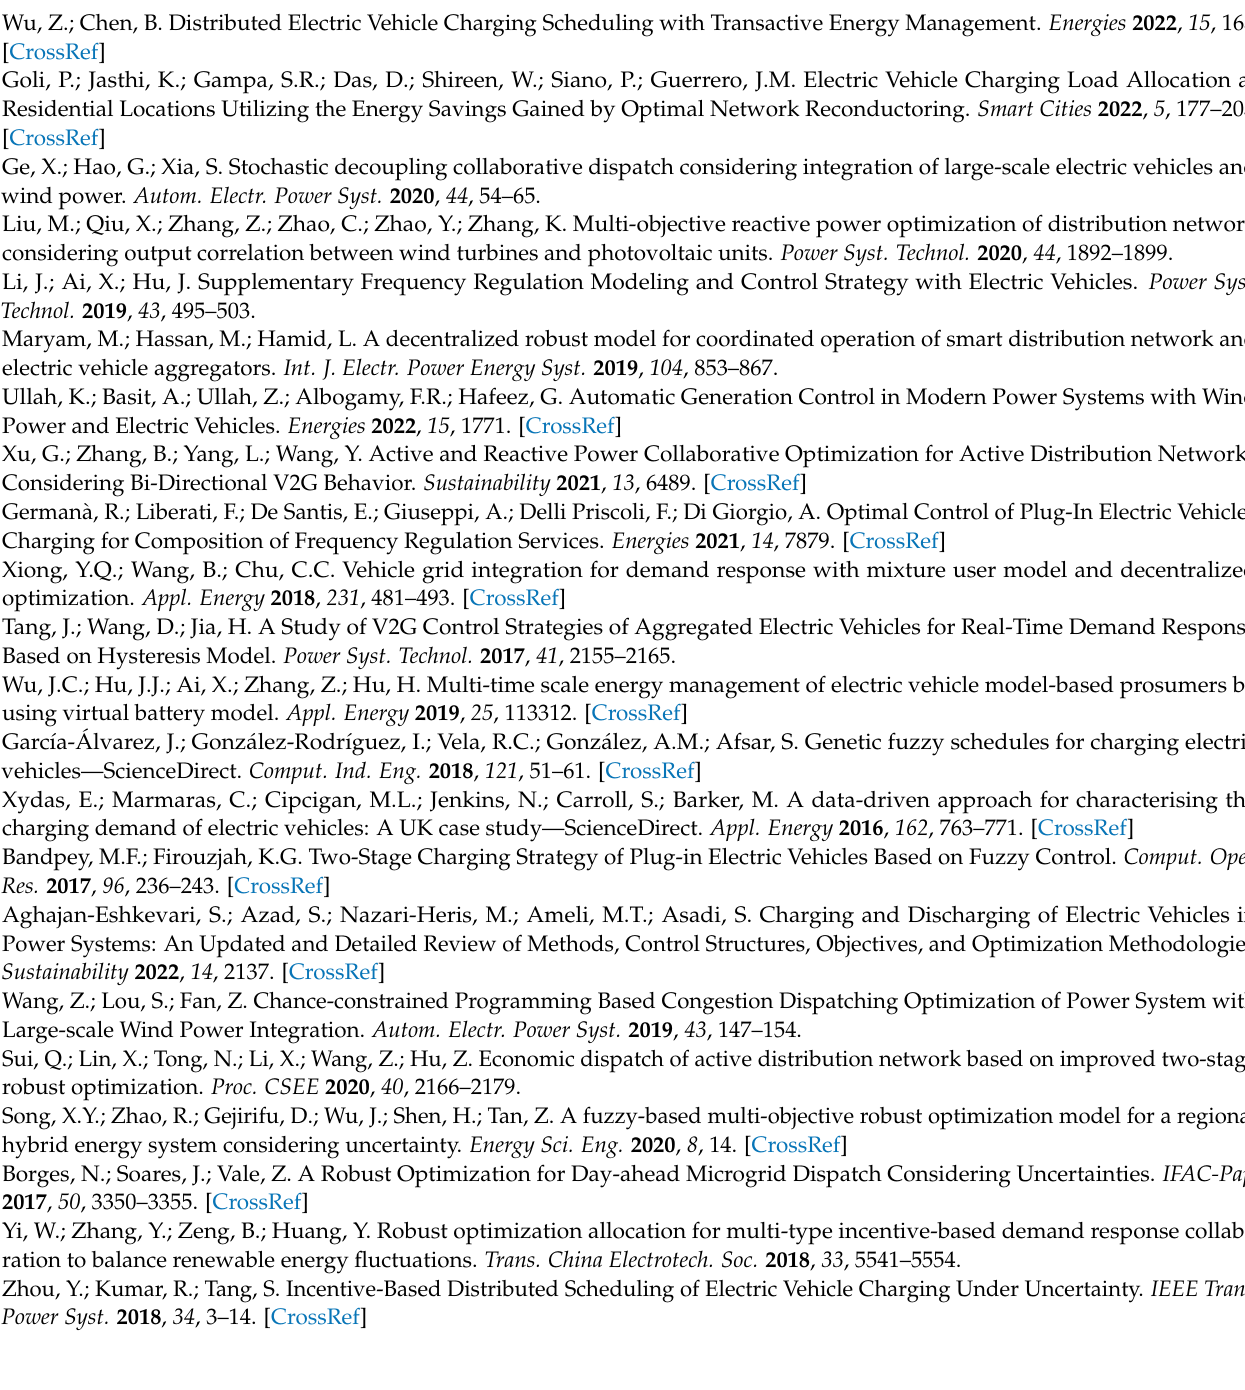
Figure A2. The numbers of three kinds of EVs.